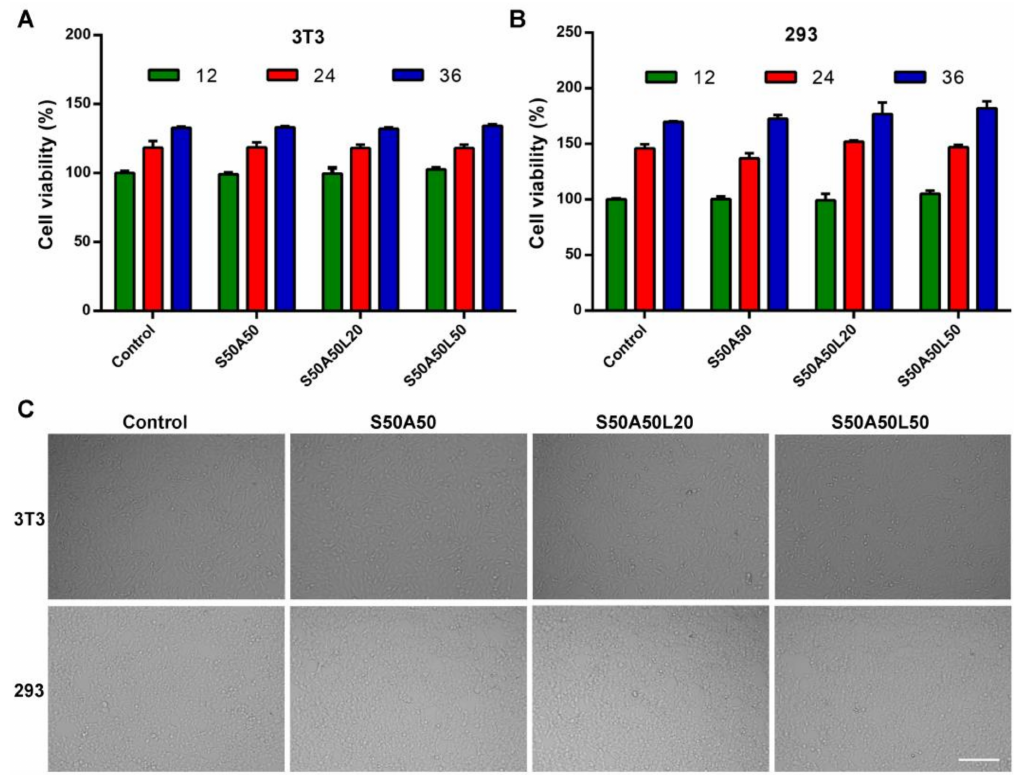
Figure 6. CCK-8 assay of the SS/AR/LZM gels. Cells viability of NIH3T3 ( A ) and HEK293 ( B ) in the presence of SS/AR gel or SS/AR/LZM gel, respectively. Microscopic analysis of NIH3T3 and HEK293 cells; (( C ), scale bar, 200 µ